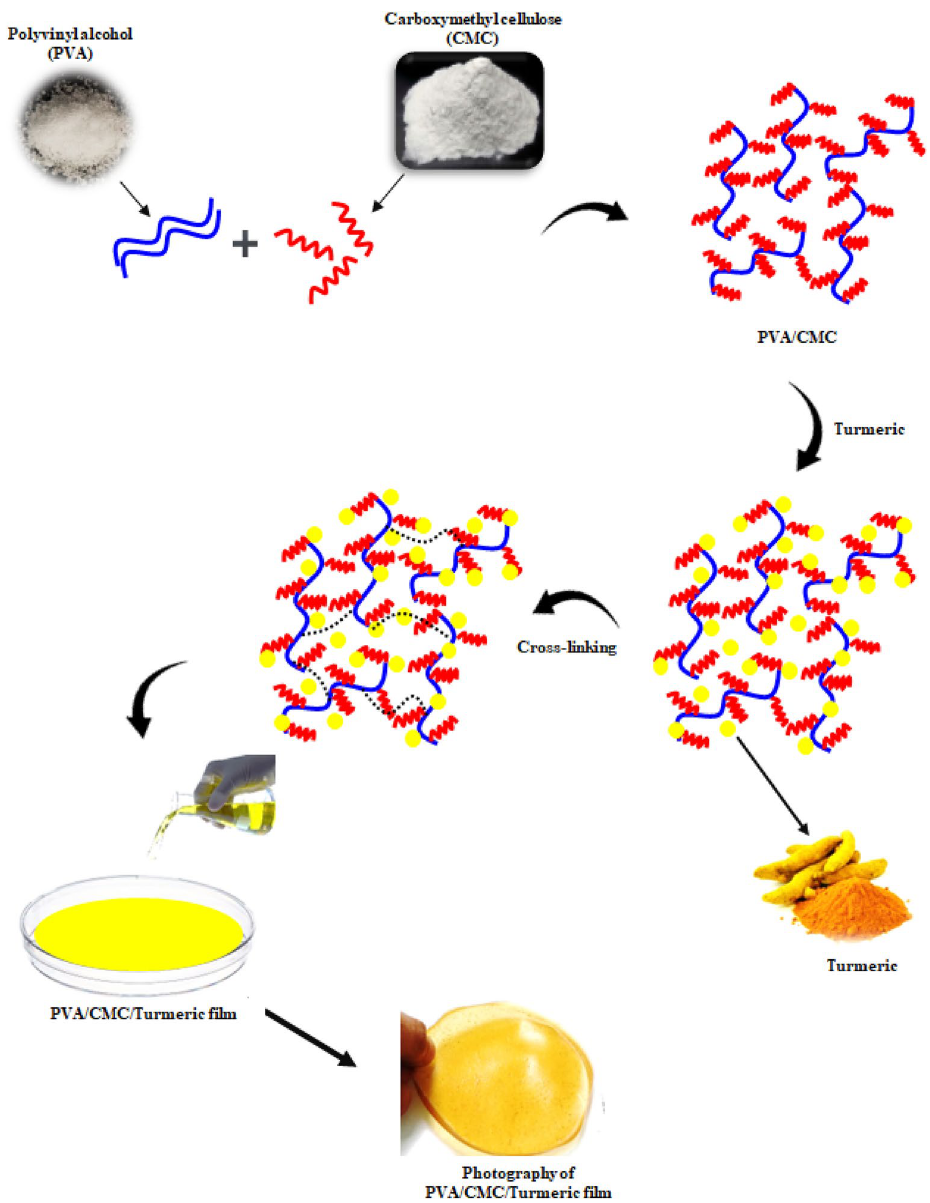
Figure 1. Schematic representation of PVA/CMC/TUR film